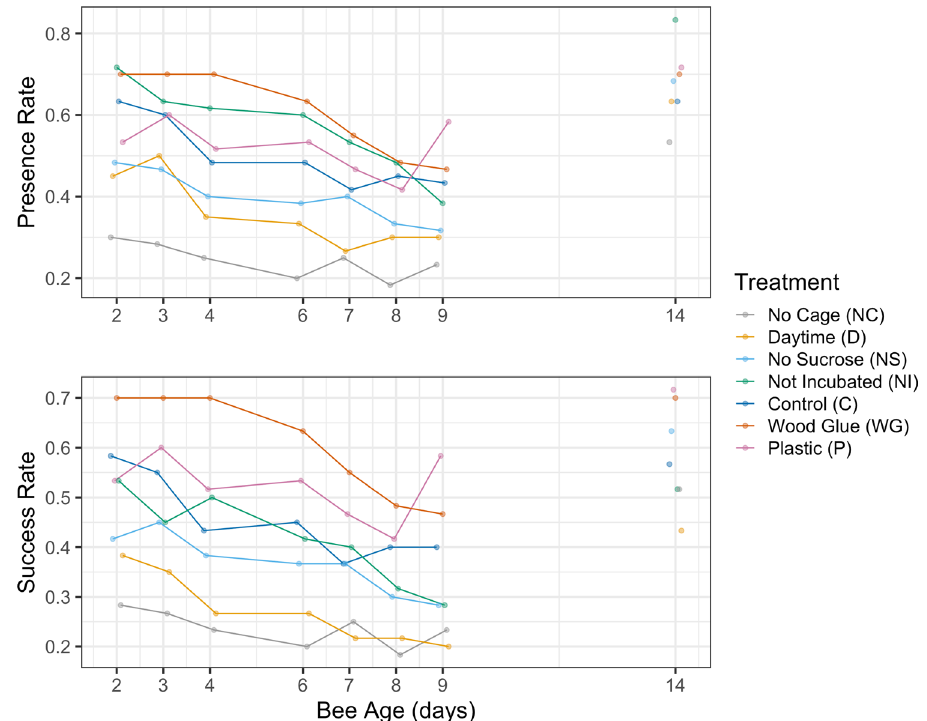
Figure 2. Presence and success for nurse bees in the seven treatment groups on the days following introduction to observation hives. Day 14 results are from the destructive sampling, where each of the three hives were frozen, and all bees inside were inspected for paint and